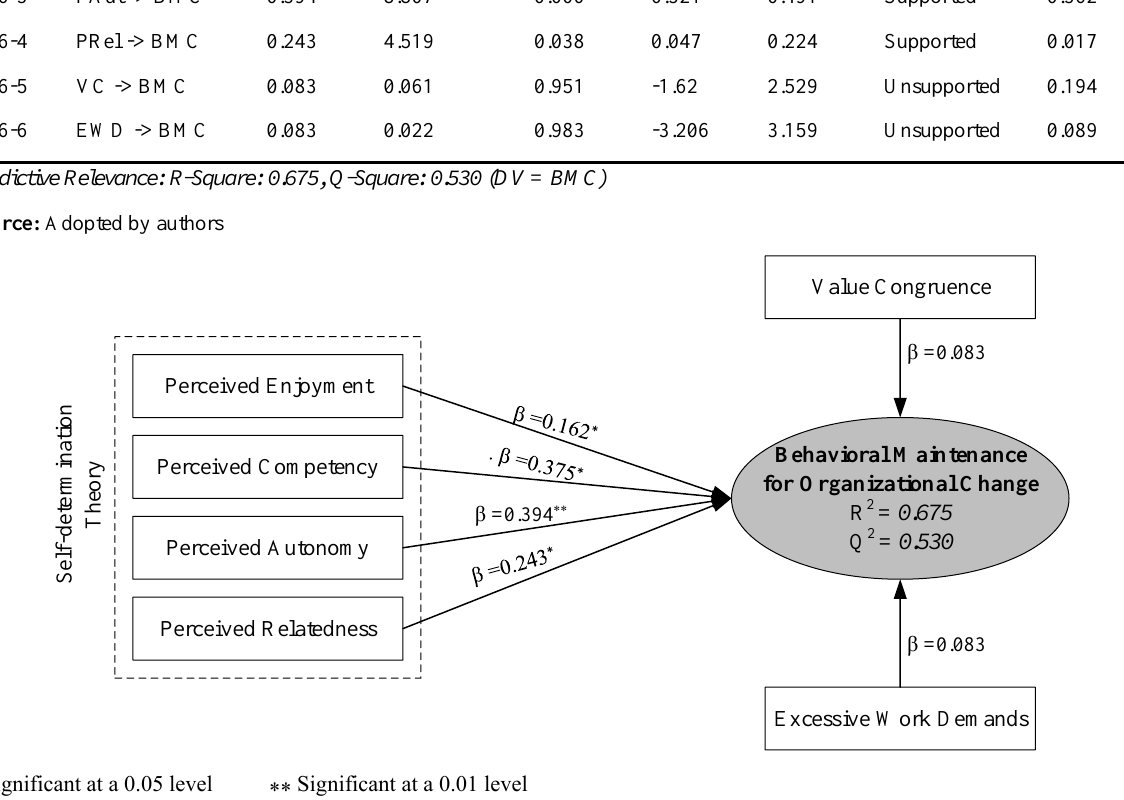
Figure 1 : Results of the Proposed Model; Source: Adopted by